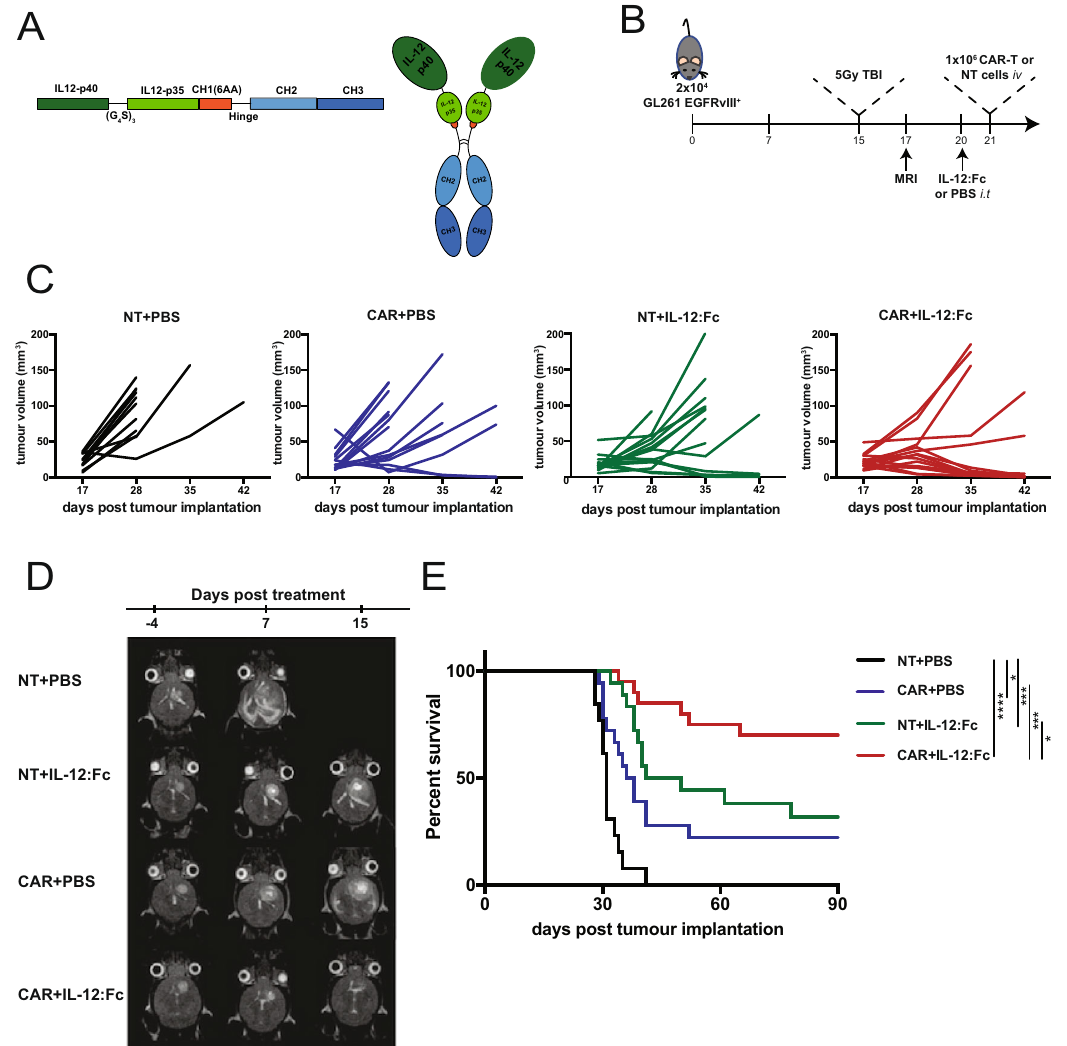
Fig. 2 Combination of EGFRvIII-speci fi c CAR-T cells and a single dose of locally administered IL-12:Fc results in effective control of late stage orthotopic tumors. A Scheme of the IL12:Fc construct inserted in the mammalian expression vector pCEP4 and a schematic representation of heterodimeric IL-12 fused to the Fc portion of murine IgG3. B Experiment timeline. GL261 EGFRvIII + cells were implanted in the right striatum at day 0. Mice received 5 Gy TBI on day 15 post implantation, while tumor engraftment was con fi rmed on day 17. On day 20, mice underwent surgery and received either PBS or 300 ng of IL-12:Fc at tumor site, followed by intravenous injection of 1 × 10 6 CAR-T cells or non-transduced cells. Tumor growth was monitored weekly. C Tumor volume quanti fi cation. D Representative MRI images (axial view) of a mouse from each group. E Survival curves (NT + PBS n = 14, CAR + PBS n = 19, NT + IL-12:Fc n = 18, CAR + IL-12:Fc n = 20 from four independent experiments, (NT + PBS vs. CAR + PBS p = 0.0375, NT + PBS vs. NT + IL-12:Fc p = 0.0001, NT + PBS vs. CAR + IL-12:Fc p < 0.0001, CAR + PBS vs. CAR + IL-12:Fc p = 0.0005, NT + IL-12:Fc vs. CAR + IL-12:Fc p = 0.0176, Log- rank test). Source data are provided as a Source Data fi